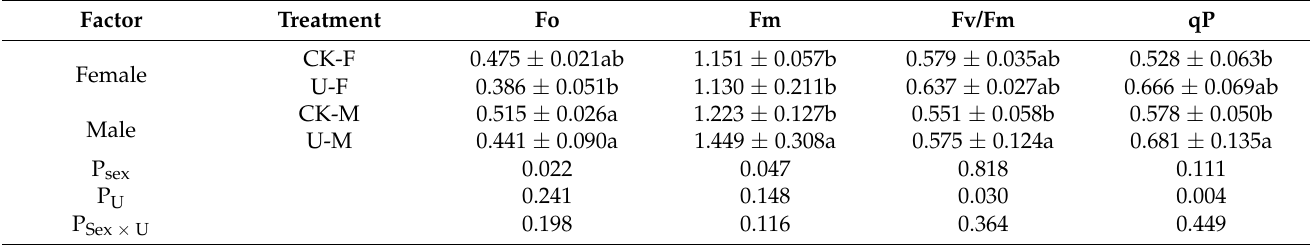
Table 3. U effects on leaf chlorophyll fluorescence parameters of P. cathayana